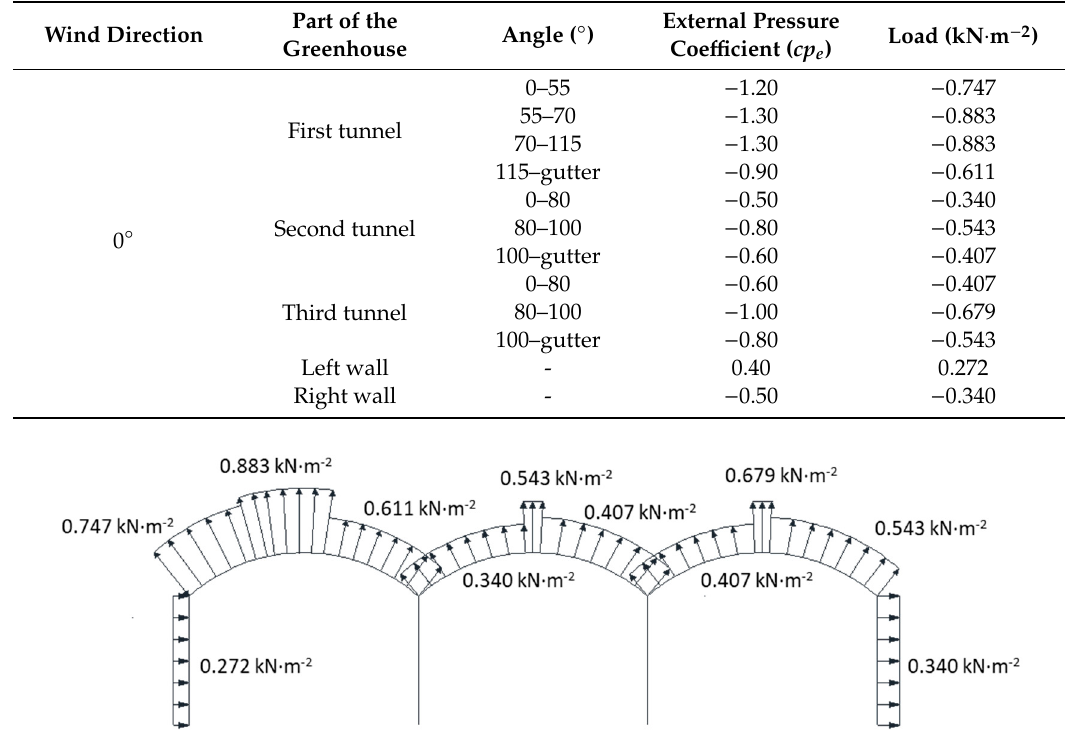
Table 3. Wind load values at 0 ◦ -direction estimated by CFD.